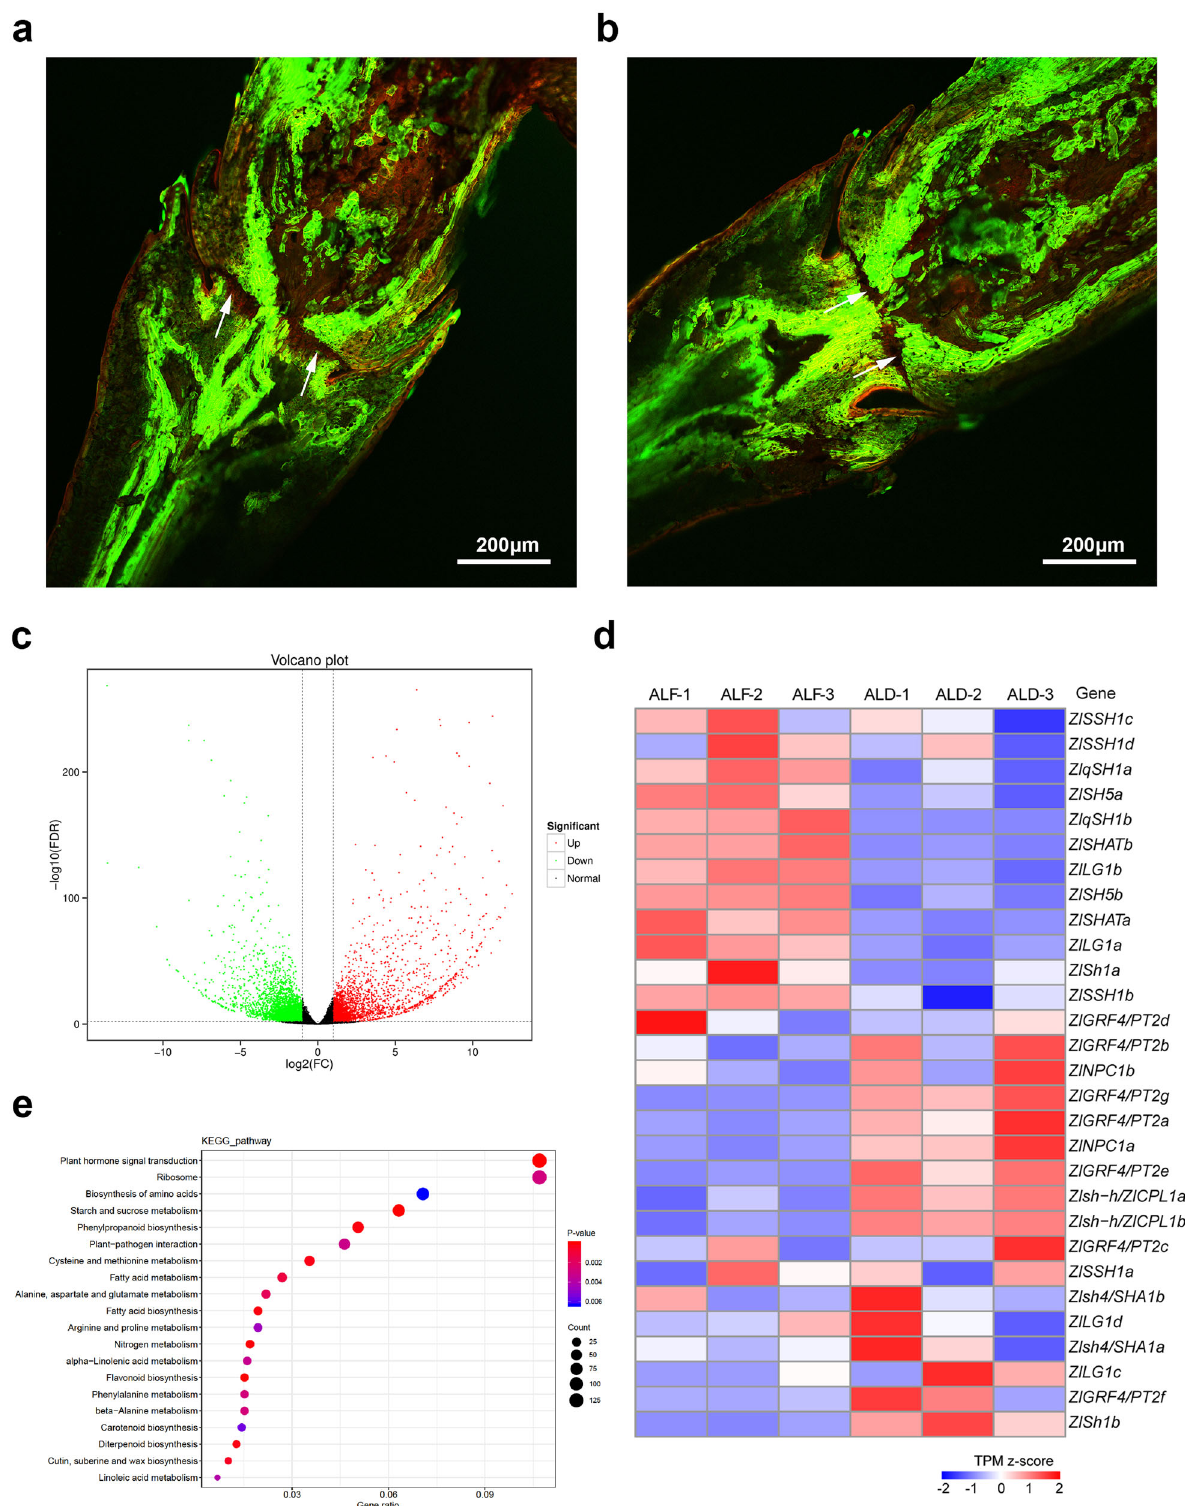
Fig. 4 Histologic and transcriptome analyses of abscission layer formation (ALF) and degradation (ALD) in Chinese wild rice. a ALF and b , ALD as revealed by staining with the cell-permeant dye Acridine Orange (green fl uorescence: dye bound to dsDNA; red fl uorescence: dye bound to ssDNA or RNA). The white arrows indicate the abscission layer. Scale bar = 200 μ m. c Volcano plot of differentially expressed genes between ALF and ALD. In this fi gure, green, red, and black dots represent genes with a low expression, high expression, and non-differentially expressed genes, respectively. d Expression levels of genes related to seed shattering between ALF and ALD. e KEGG enrichment bubble plot of differentially expressed genes between ALF and